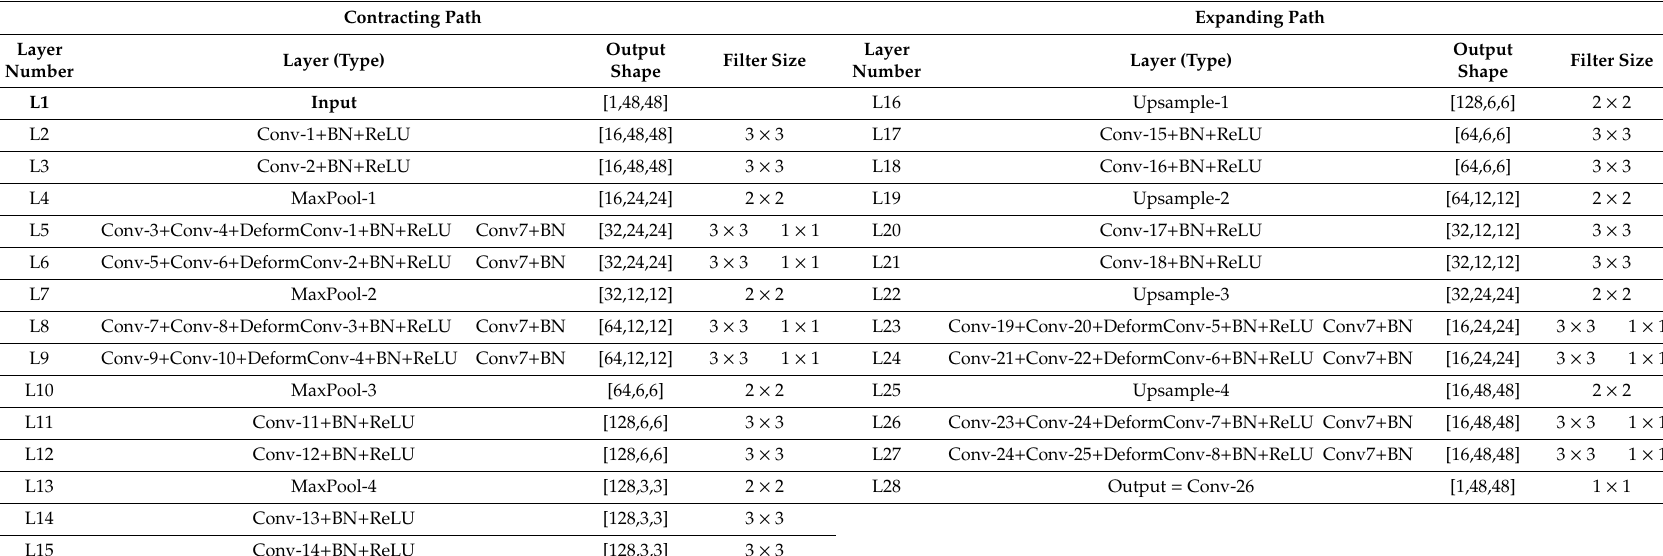
Table 1. Network structure of